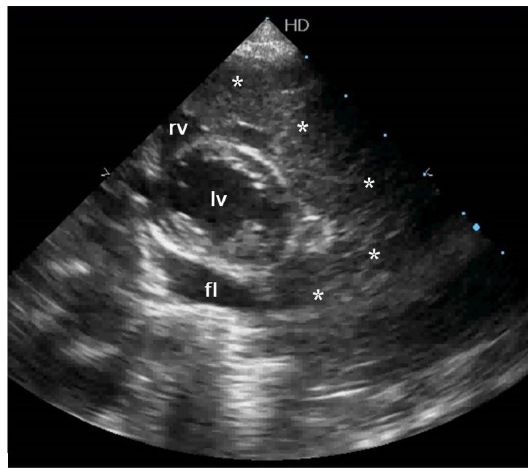
Figure 1. Right transversal parasternal view in echocardiographic examination, highlighting the presence of a large structure (*) attached to the heart. Other structures referenced: right ventricle (rv) and left ventricle (lv). Note the presence of free liquid (fI) in the thoracic